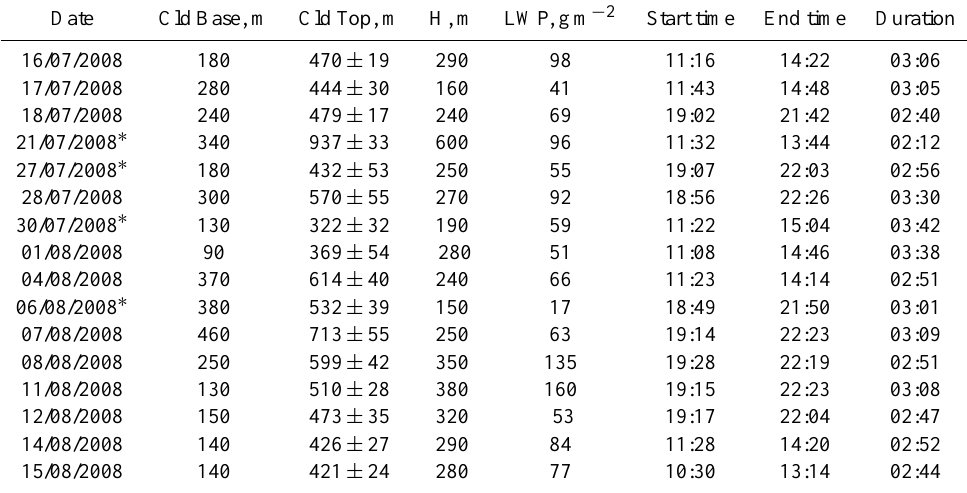
Table 1. Information for each flight. Cloud top denotes mean and standard deviation of cloud top used for the altitude shifting the sawtooth data. The start and end times identify the beginning and end of the sawtooth legs, not the takeoff and landing times. These times are all listed as local time (Pacific Daylight Time). UTC=PDT+7h. The day flights typically are on station in the vicinity of mid-day, while the night flights are on station from before sundown to mid-evening. Sunset ranges from 20:30PDT in mid-July to 20:00PDT in mid-August. The ∗ denotes flights presented in Figs. 2 to 5.